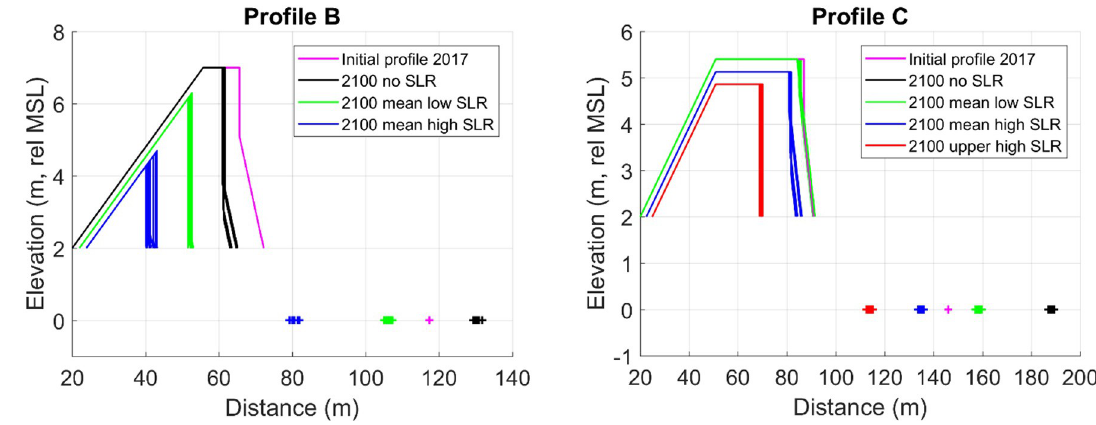
Fig 17. Simulated beach–dune evolution for profile B and C. The ‘+’ indicates intersection with MSL.